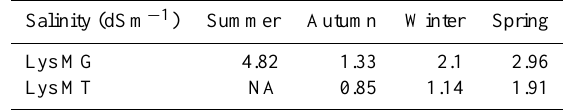
Fig. 5. Seasonal variation of water quality indicators in zone MG. ∗ Potassium, nitrite, nitrate, TDS, total N and P are in grams. Fig 5. Seasonal variation of water quality indicators in zone MG 644 Table 2. Seasonal salinity of drained water from two lysimeters. Salinity (dSm − 1 )